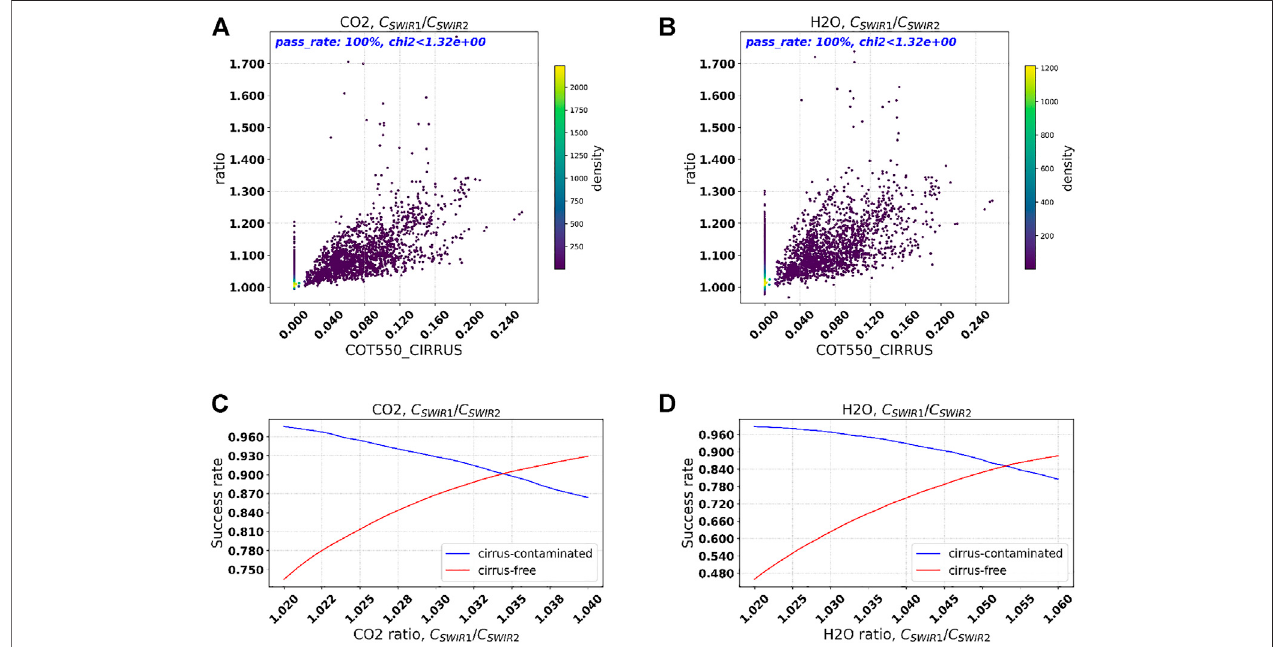
FIGURE4| Non-scatteringretrievalsofCO 2 ratioandH 2 OratioofthecolumnatSWIR-1bandtothecolumnatSWIR-2band.TheupperpanelshowstheCO 2 ratio (A) and H 2 O ratio (B) as a function of COT. The lower panel shows the success rates of fi ltering cirrus-contaminated pixels for different cases by different values of CO 2 ratio (C) and H 2 O ratio (D)